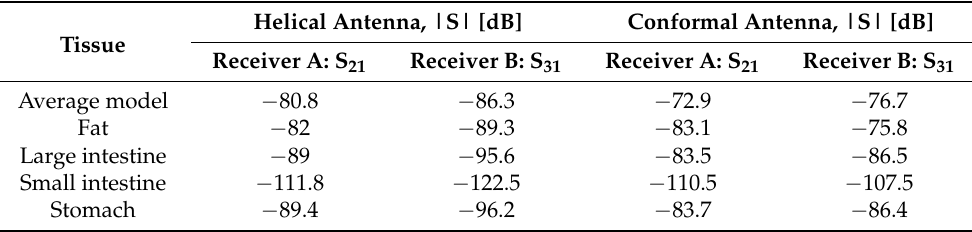
Figure 10. Antenna verification setup ( a ) simulation setup with S parameters definition, ( b ) measurement setup. Table 3. The attenuation of signal between antennas (S parameters) for different tissues.